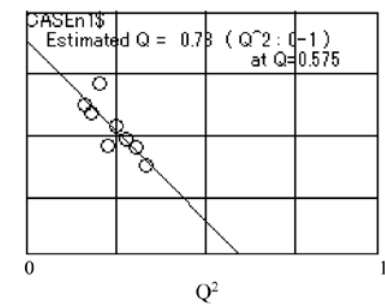
Fig. 4. Results of simulation